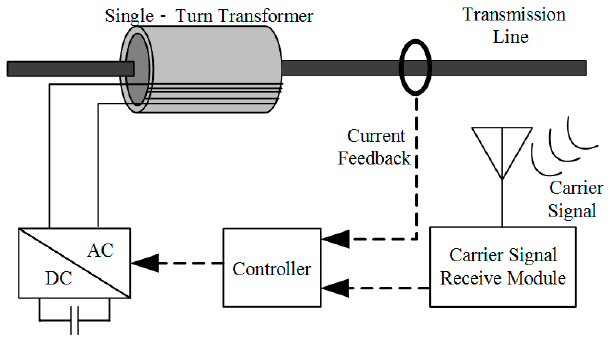
Figure 4. The structure of the DPFC series unit.